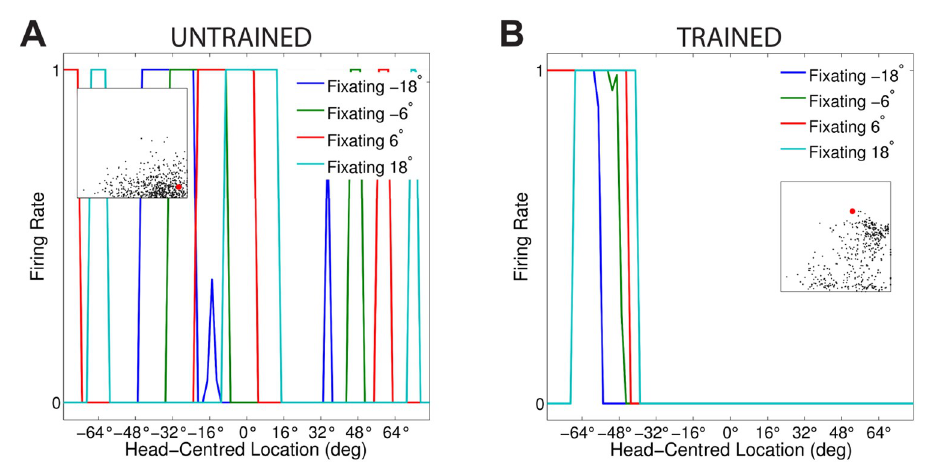
Fig 15. Simulation results showing the firing rate responses of a model incorporating a population of monotonic modulated input neurons trained with the modified learning rule 18: Delayed postsynaptic firing rate with anti- Hebbian learning. The figure shows the firing rate responses of output neuron #876 before training (A) and after training (B) during testing for four different eye-positions: − 18˚, − 6˚, 6˚ and 18˚. Conventions as for Fig 12. The comparison of subplot (A) and subplot (B) shows that the output neuron learned to respond to a specific head-centred location regardless of the eye-position after training.